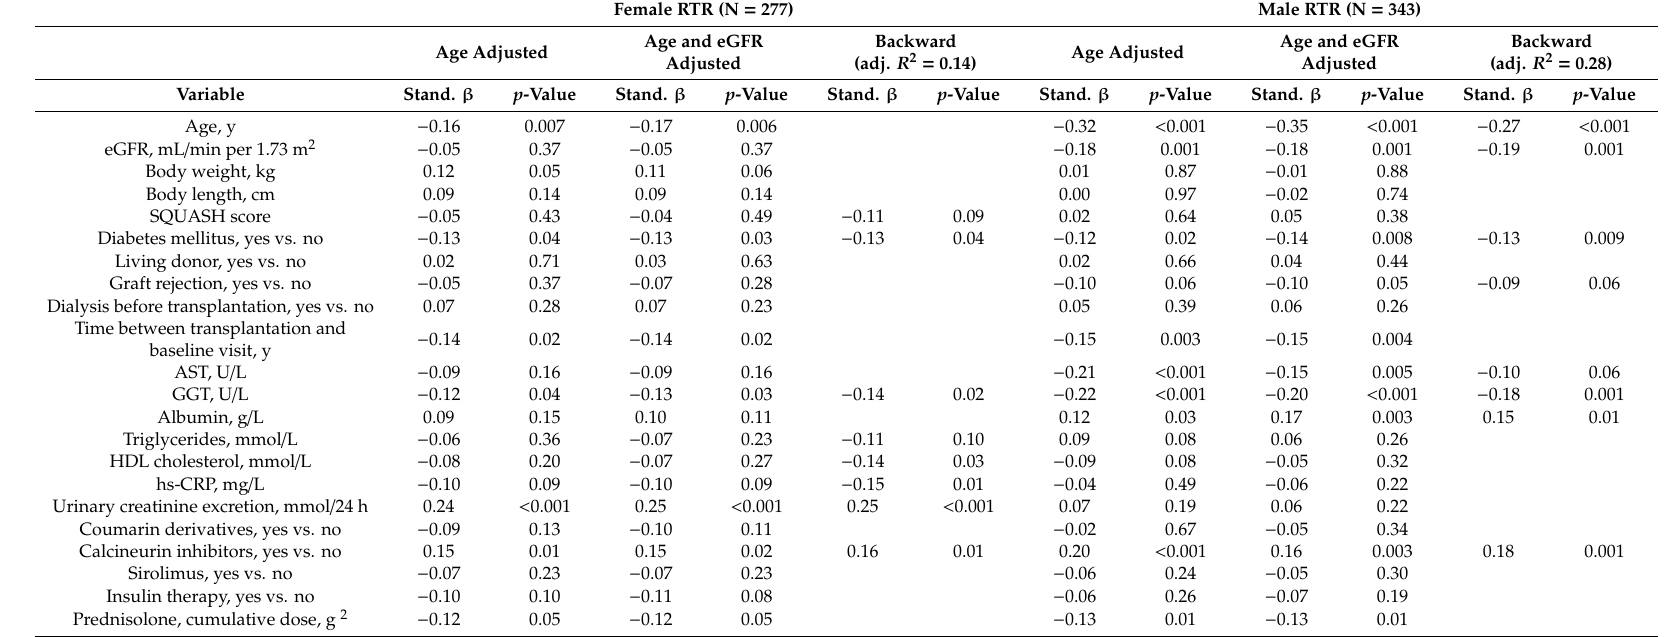
Table 2. Multivariable linear regression analysis with plasma IGF1 as the dependent variable in female and male RTR 1